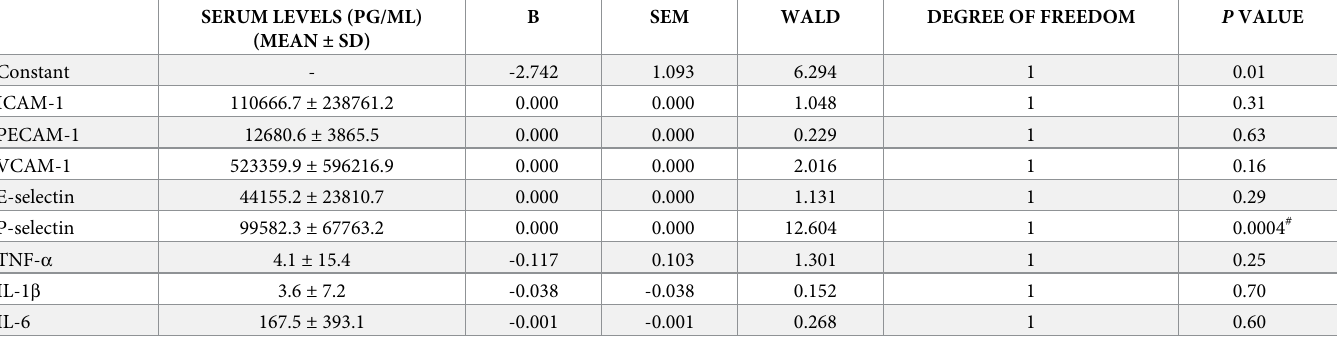
effect [27]. Therefore, PECAM-1 might play a crucial role in the progression of the anatomical CNS damage, observed subsequently to delirium onset. Moreover, PECAM-1 could be consid- ered as a potential therapeutic target for protecting the CNS from the cytotoxicity exerted by the immune cells and preventing the sustained cognitive impairment observed in conjunction with brain atrophy, even later than 6 months after surgery [28,29]. Thus, our present findings Table 2. Results of logistic regression analysis on all participants to identify independent biomarkers contributing to serum pNF-H detection during postoperative periods. SERUM LEVELS (PG/ML) (MEAN ±